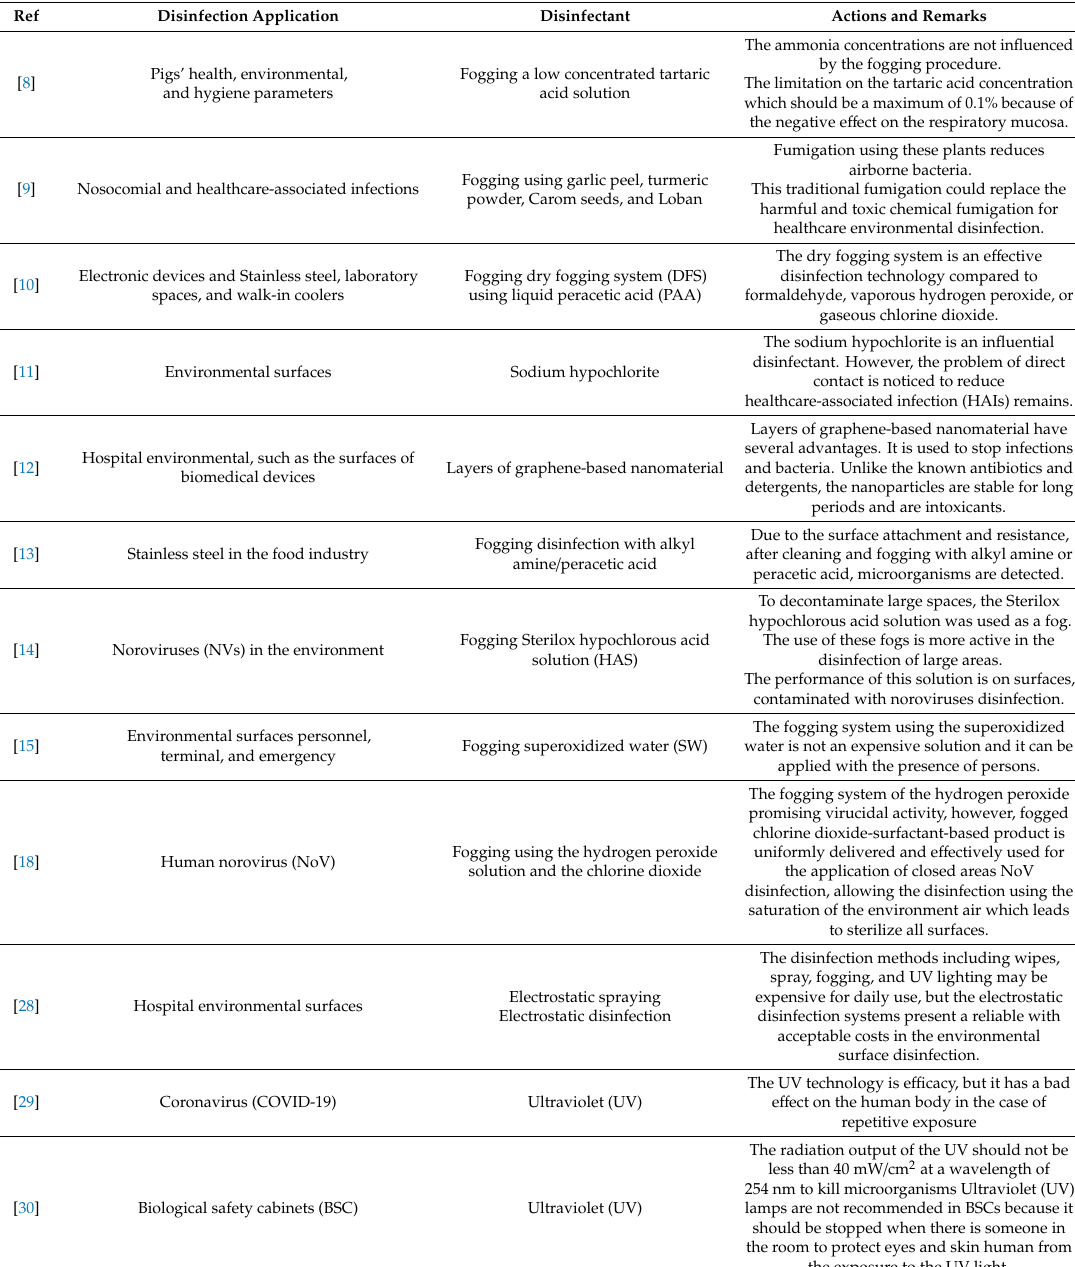
Table 1. Examples of disinfectant solutions and